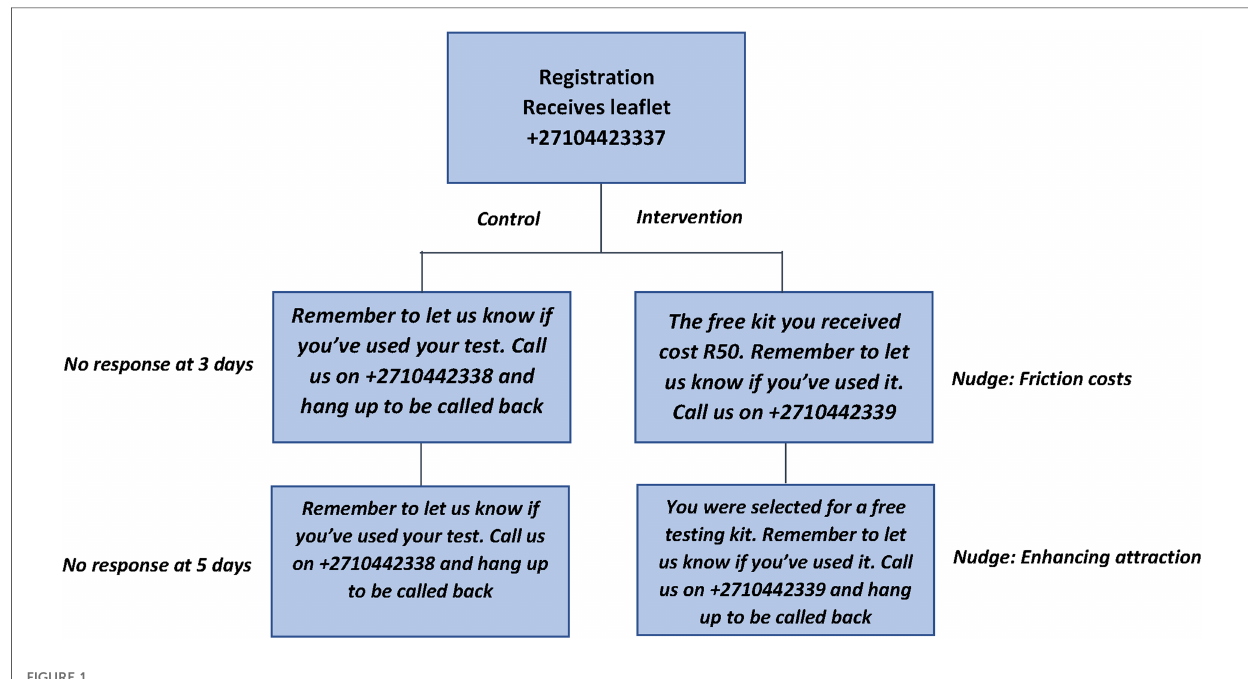
FIGURE 1 Work fl ow design of behavioural SMS received by